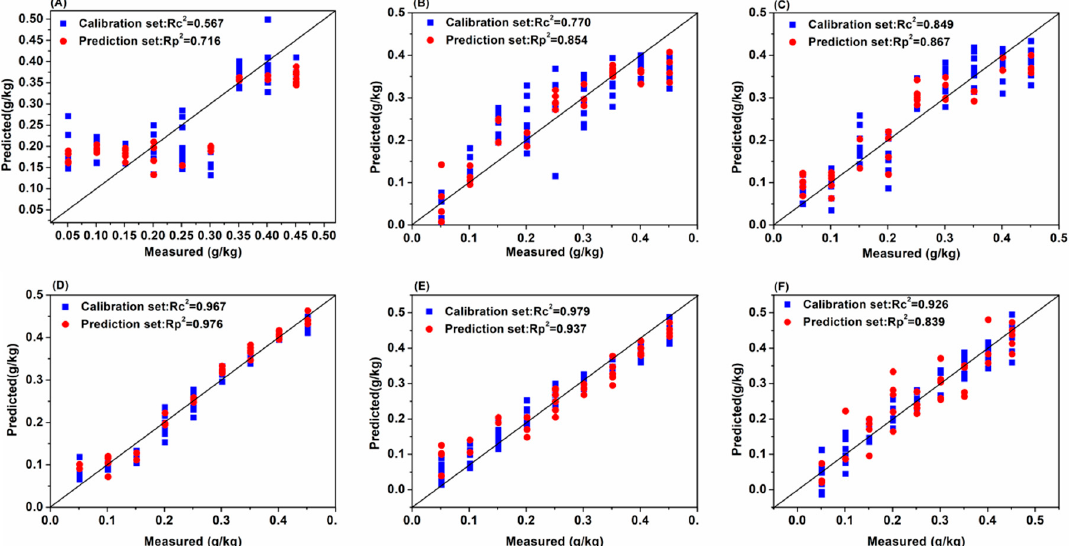
Figure 6. The predicted values and the measured values of the correction set and the prediction set based on PLS (original spectra). Soil particle sizes: ( A ) 1–2 mm; ( B ) 0.45–1 mm; ( C ) 0.28–0.45 mm; ( D ) 0.18–0.28 mm; ( E ) 0–0.18 mm; ( F ) 0–2 mm.